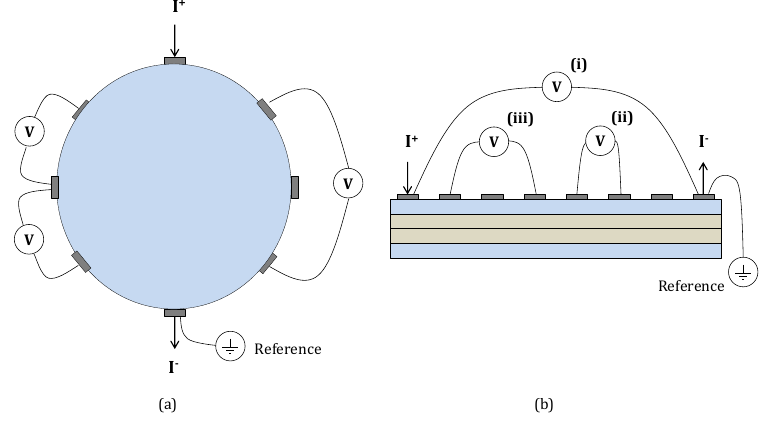
Figure 1. Electrical Resistance Tomography (ERT): ( a ) General example; ( b ) in a